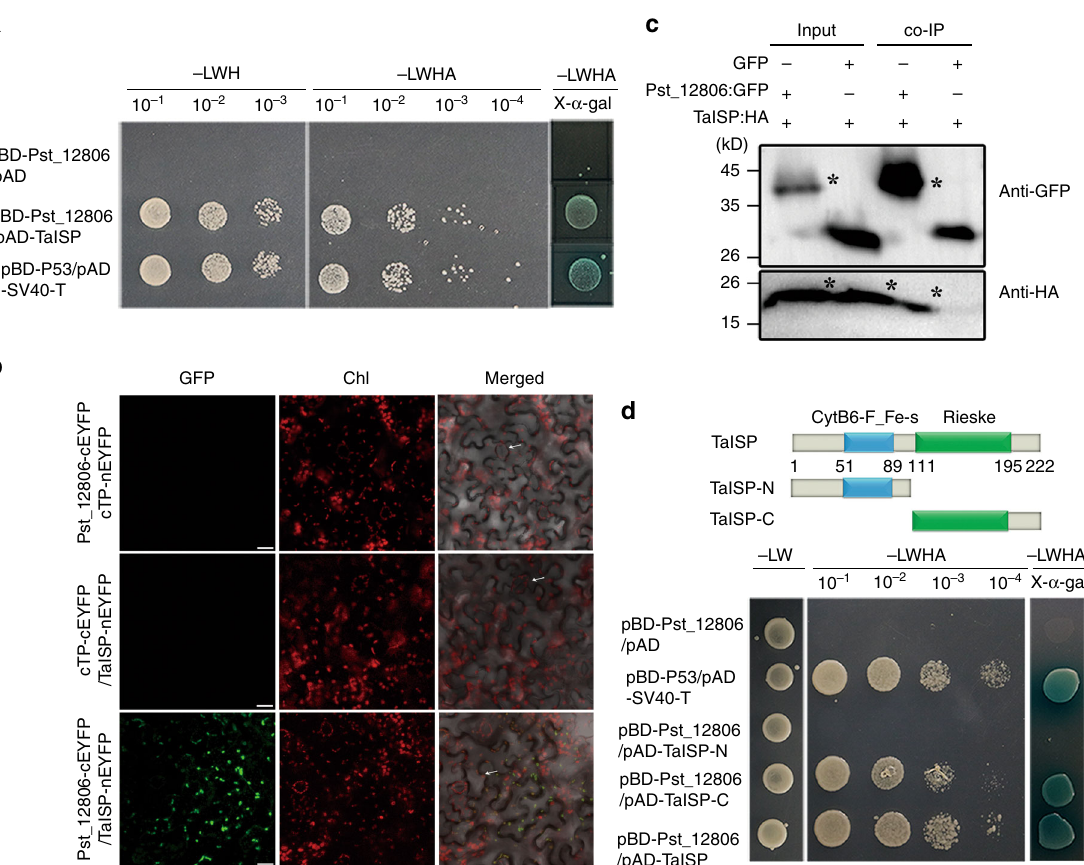
Fig. 5 Pst_12806 interacts with TaISP in vivo. a Detection of the interaction between Pst_12806 and TaISP by yeast two-hybrid assays. Yeast cells of AH109 strain transformed with the labeled constructs were assayed for growth on SD medium lacking LWH or LWHA and LacZ activities on SD-LWHA with X- α -gal. b Detection of the Pst_12806 – TaISP interaction in chloroplasts of N. benthamiana leaves transiently expressing the marked constructs by bimolecular fl uorescence complementation (BIFC) assays. These arrows marked guard cells. Bar = 20 μ m. c Con fi rmation of the interaction between Pst_12806 and TaISP by co-immunoprecipitation assays. Western blots of total proteins from N. benthamiana leaves transiently expressing the marked constructs and proteins eluted from magnetic beads were detected with the anti-GFP or anti-HA antibody. The sizes of Pst_12806:GFP and TaISP:HA bands (marked with asterisk) were 41 and 24 kD, respectively. The protein marker was labeled on the left. d Yeast transformants expressing the labeled constructs of Pst_12806 and Rieske domains of TaISP were assayed for growth on SD-LWH or SD-LWHA and LacZ activities on SD-LWHA with X- α -gal. TaISP-N contains the N-terminal region of TaISP with the CytB6-F_Fe-S domain. TaISP-C contains the C-terminal region of TaISP with the Rieske domains. L leucine, W tryptophan, H histidine, A adenine, Chl